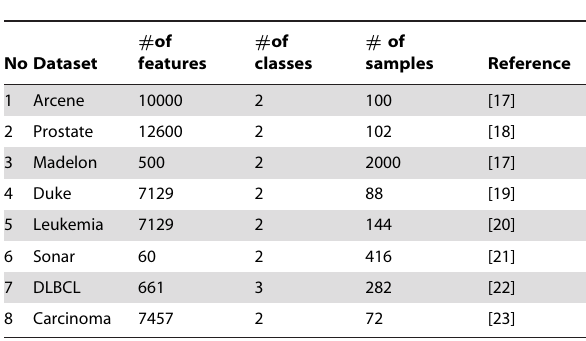
Table 1. Summary of the benchmark